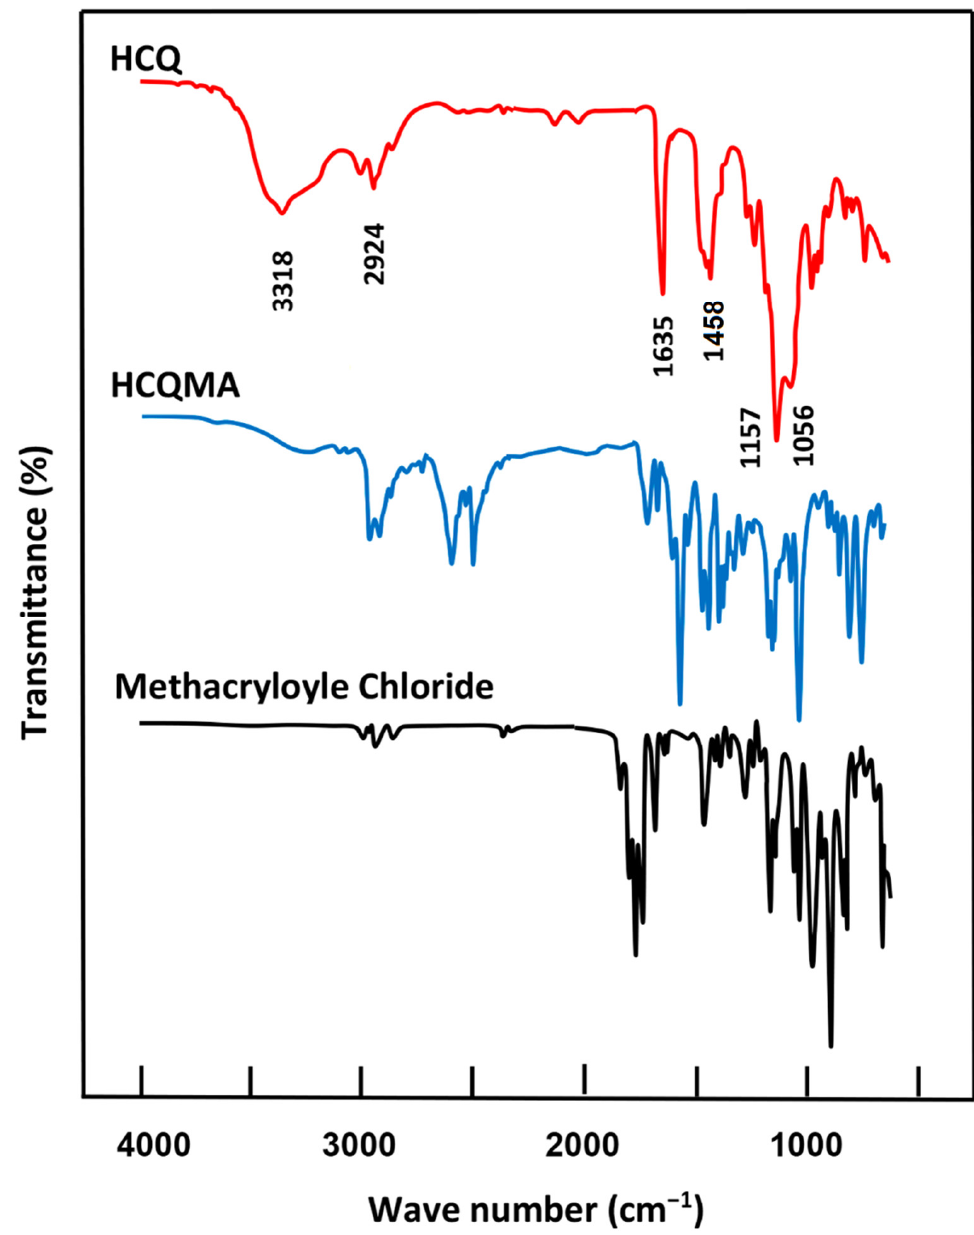
Figure 1. FTIR spectra of CQMA, HEMA monomers, pure HCQ and pure methacroyle chloride.